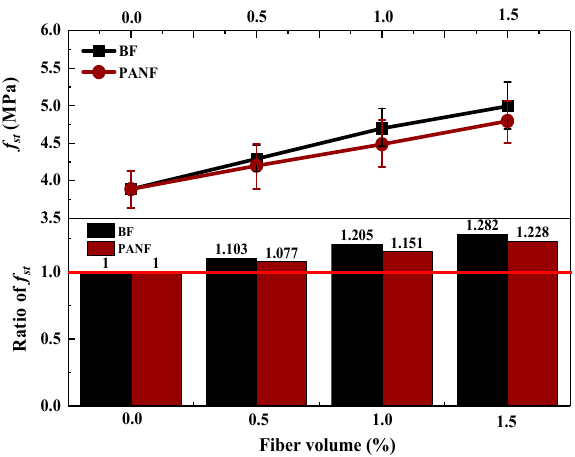
Figure 7. Effect of BF and PANF on splitting tensile strength of LWACs.